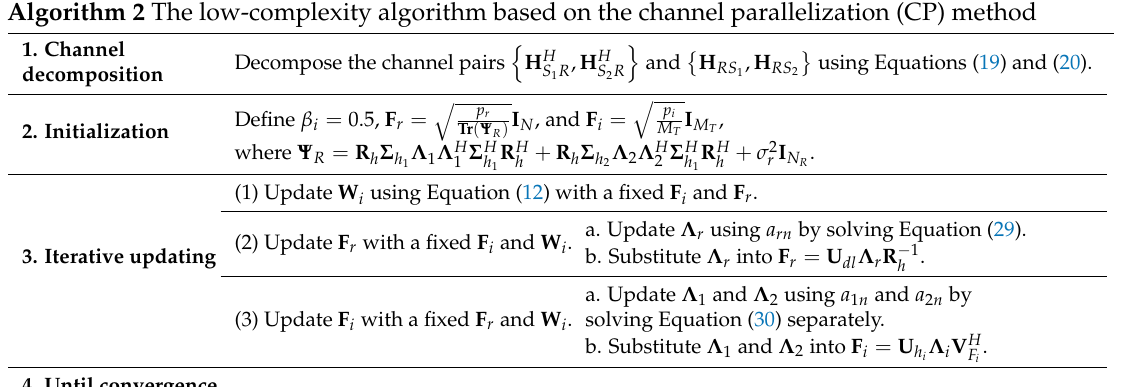
Algorithm 2 The low-complexity algorithm based on the channel parallelization (CP)